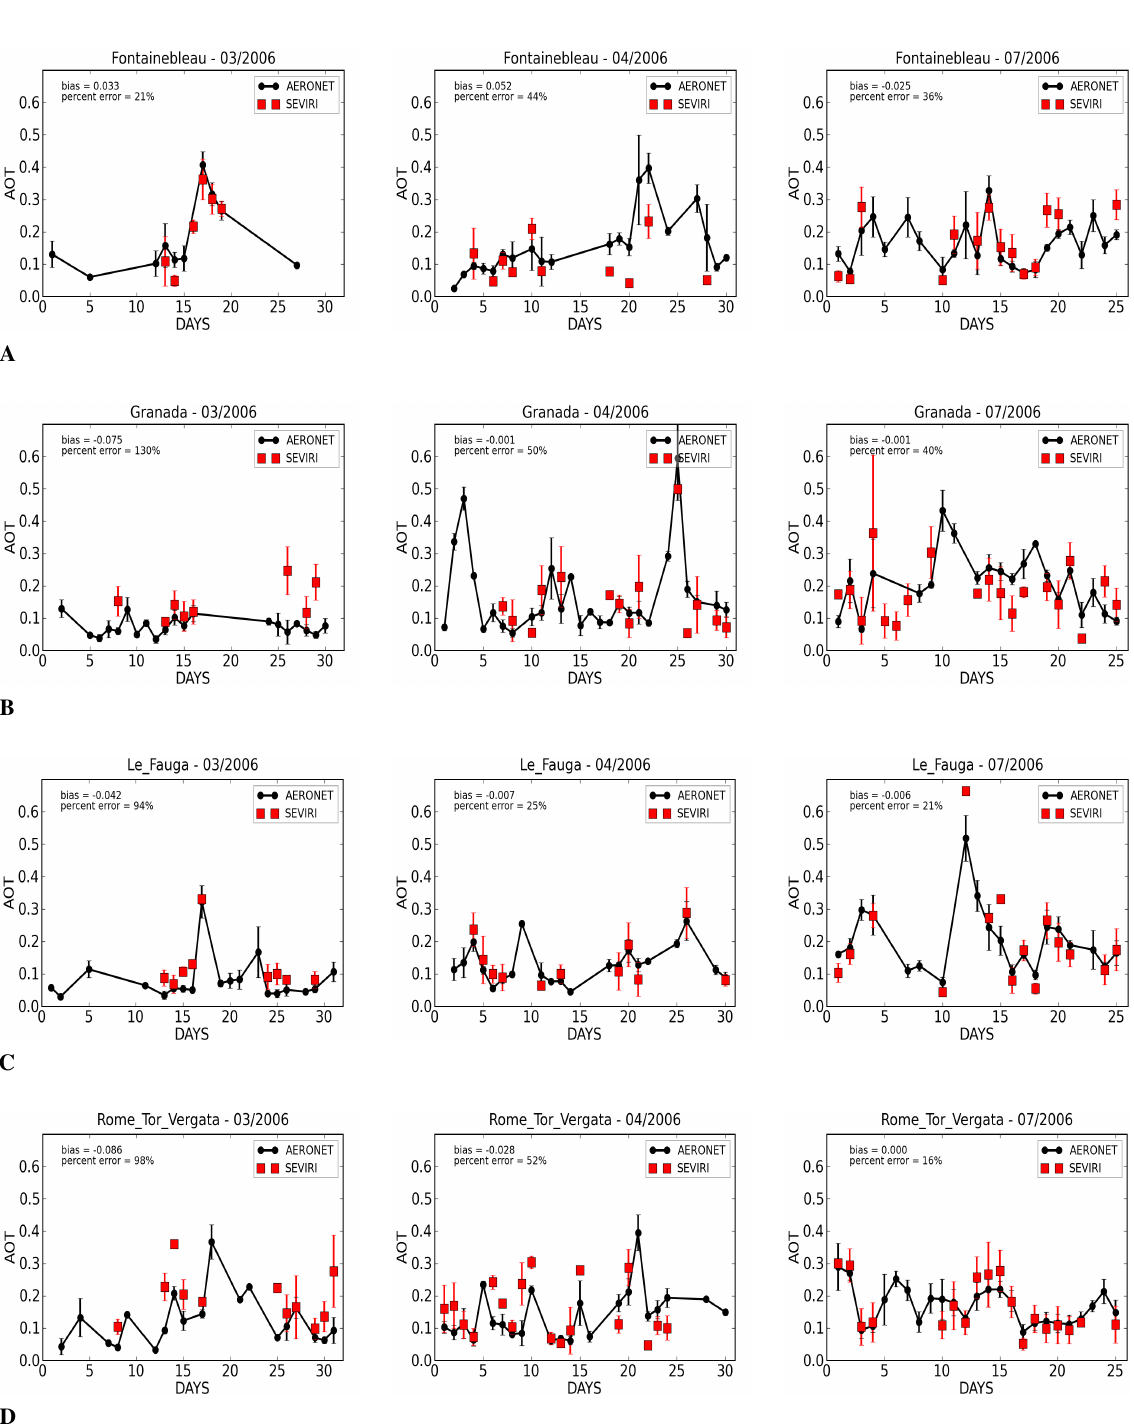
Fig. 11. Temporal evolution of the daily averaged AOT for 4 AERONET stations in March, April and July 2006. Stations are Fontainebleau [ A ], Granada [ B ], Le Fauga [ C ] and Rome Tor Vergata [ D ]. The black curve is the AOT AERONET and the red one is the AOT SEVIRI. The standard deviations are also plotted. The averages are made independently for AERONET and SEVIRI. Atmos. Meas. Tech., 4, 2543–2565,